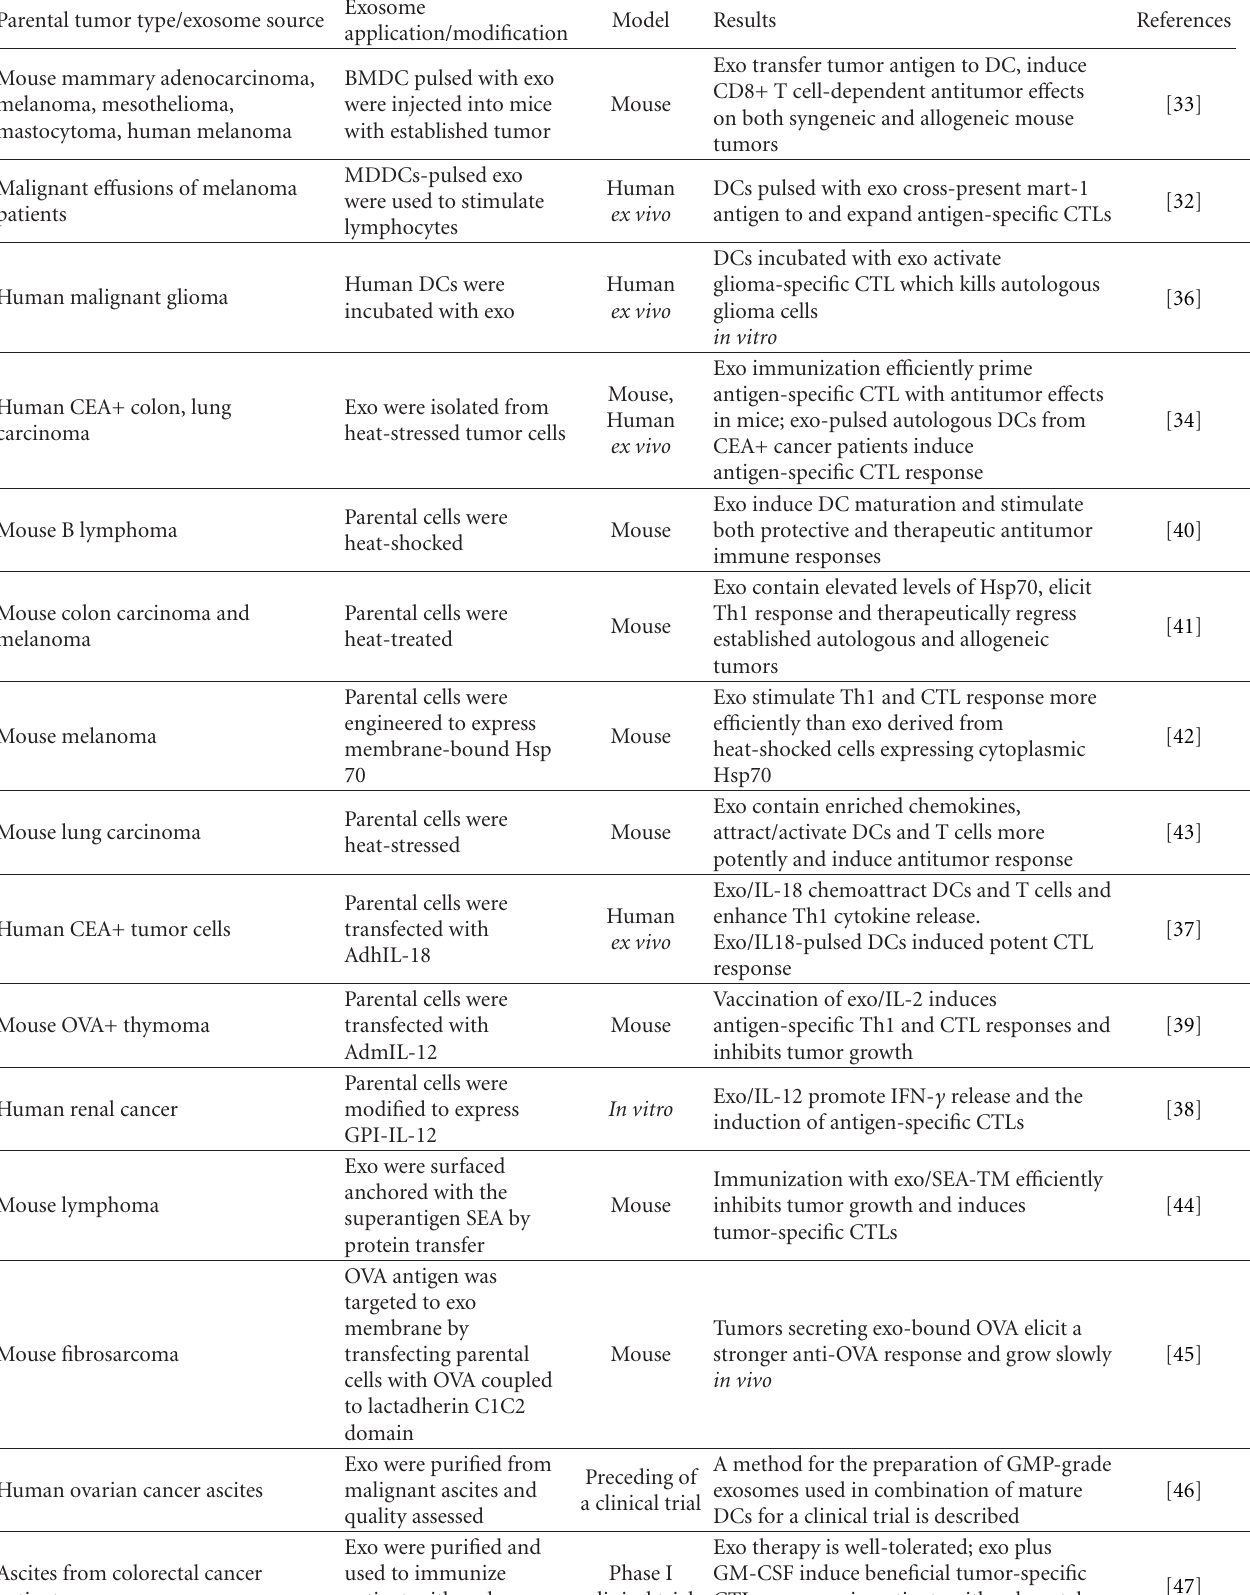
Table 1: Representative studies on the immunogenicity of tumor-derived exosomes and tumor exosome-based cancer vaccines. Exosome Parental tumor type/exosome source